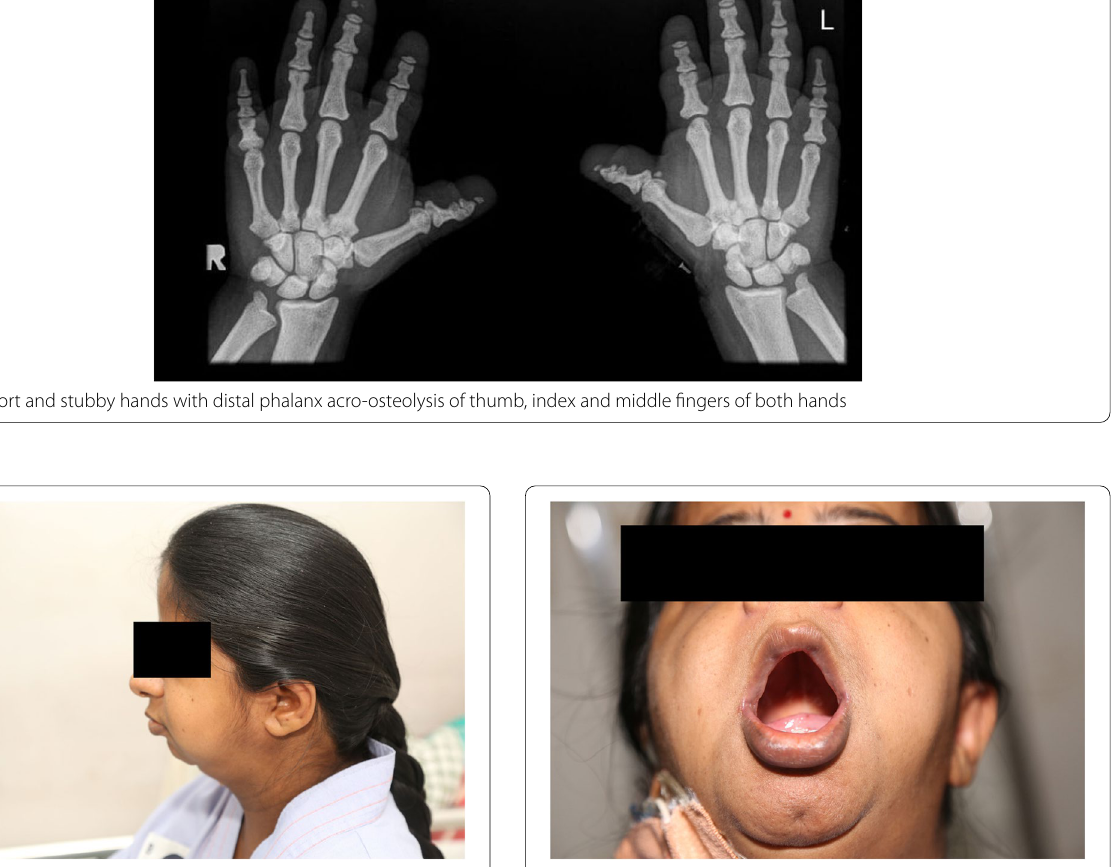
Fig. 2 Lateral profile with retrognathia and micrognathia Fig. 3 Mouth opening with high-arched